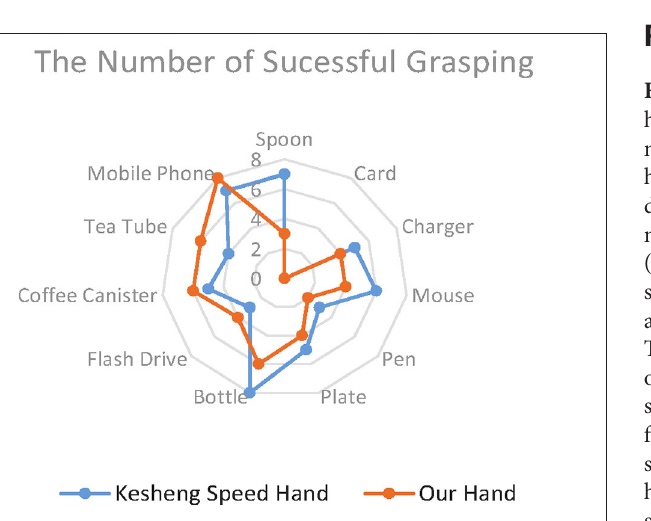
button and earned a score of 1; (3) the amputee then picked up the object from the right square and put it back in the left square; (4) after successfully doing this, the amputee pushed the left red button and earned another score of 1. Each amputee was asked to repeat procedures (1), ..., (4) to get as high a total score as possible in 1